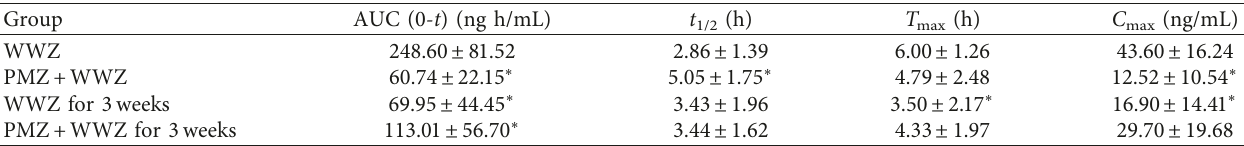
Table 7: Pharmacokinetic parameters of schisandrin in rats after oral administration of the S. chinensis water extract once or for con- tinuously three weeks, coadministered with or without PMZ ( n � 6-7).